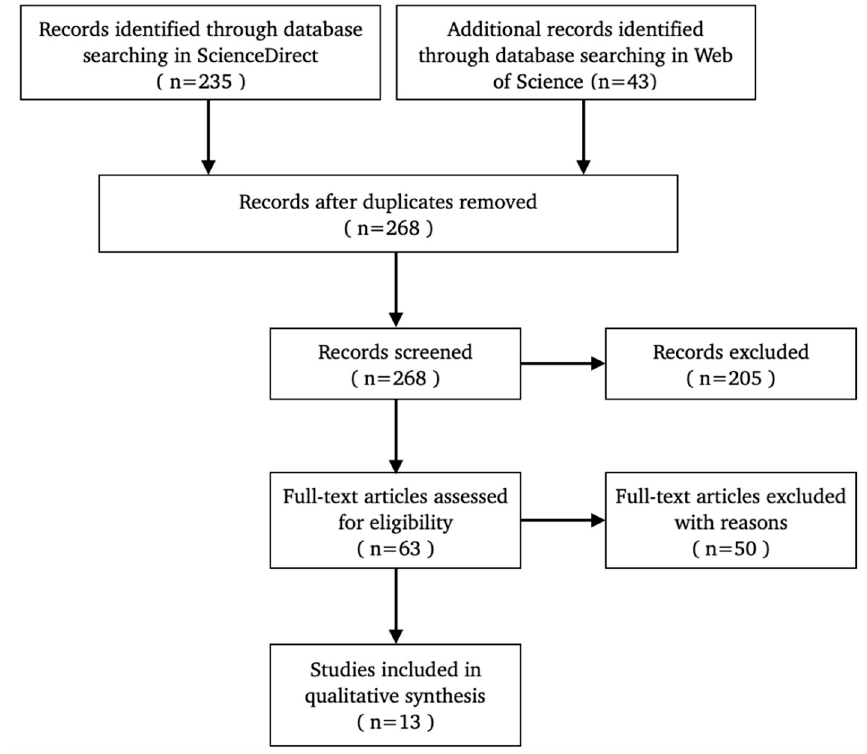
Figure 2. Flow chart of study selection process.